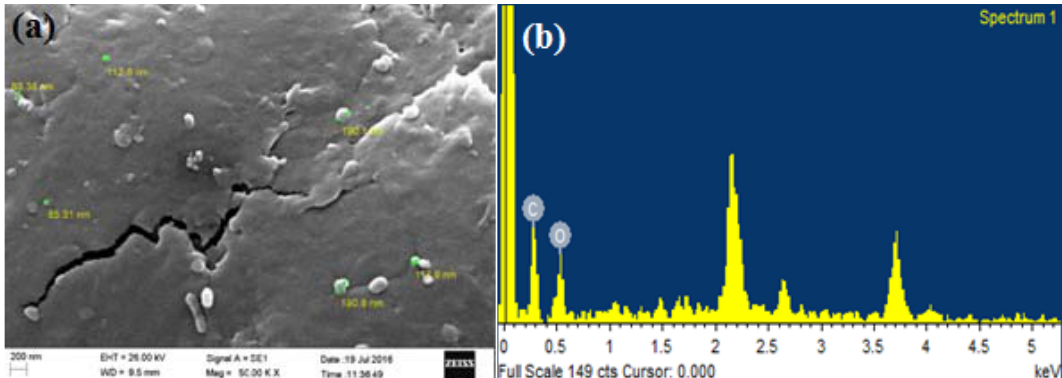
Fig 2. FE-SEM (a) and EDS spectrum (b) images of chitosan NPs.